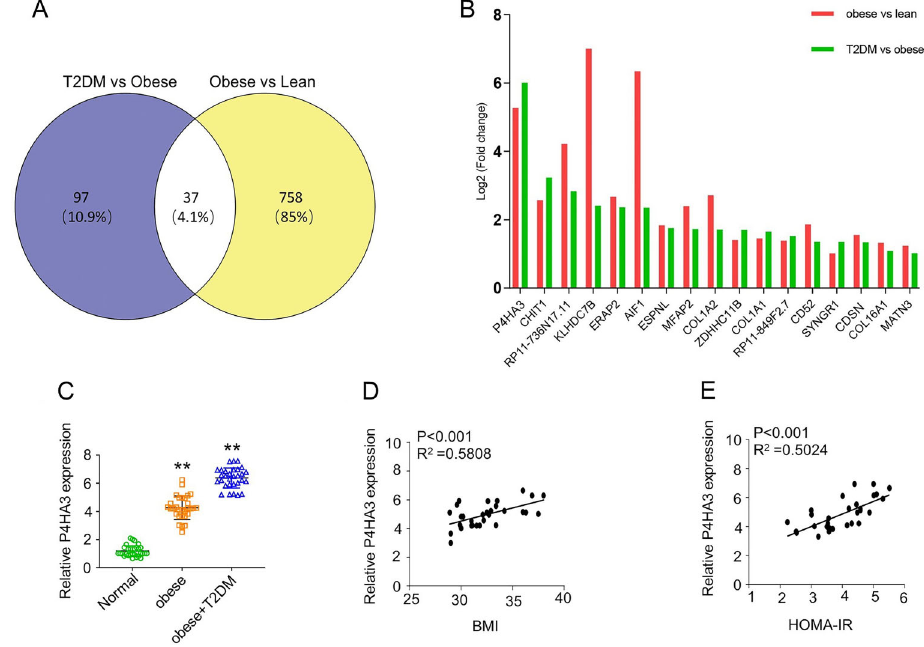
Figure 1. P4HA3 was signi fi cantly upregulated in obese and type 2 diabetes mellitus (T2DM) patients. A , Venn diagram of the differentially expressed (DE) genes in 2 pairwise comparisons: lean obese, obese (non-diabetic) vs diabetic. B , Top ranked DE genes in both groups (|logFC| X 1 and P o 0.05), with their log 2 fold-changes. C , P4HA3 expression in adipose tissue from 30 individuals with normal body mass index (BMI), 30 obese patients, and 30 obese patients with T2DM. Pearson correlation between P4HA3 expression level in adipose tissue and BMI in 30 obese patients ( D ) and between P4HA3 expression level in adipose tissue and Homeostatic Model Assessment for Insulin Resistance (HOMA-IR) of 30 obese with T2DM patients ( E ). **P o 0.01